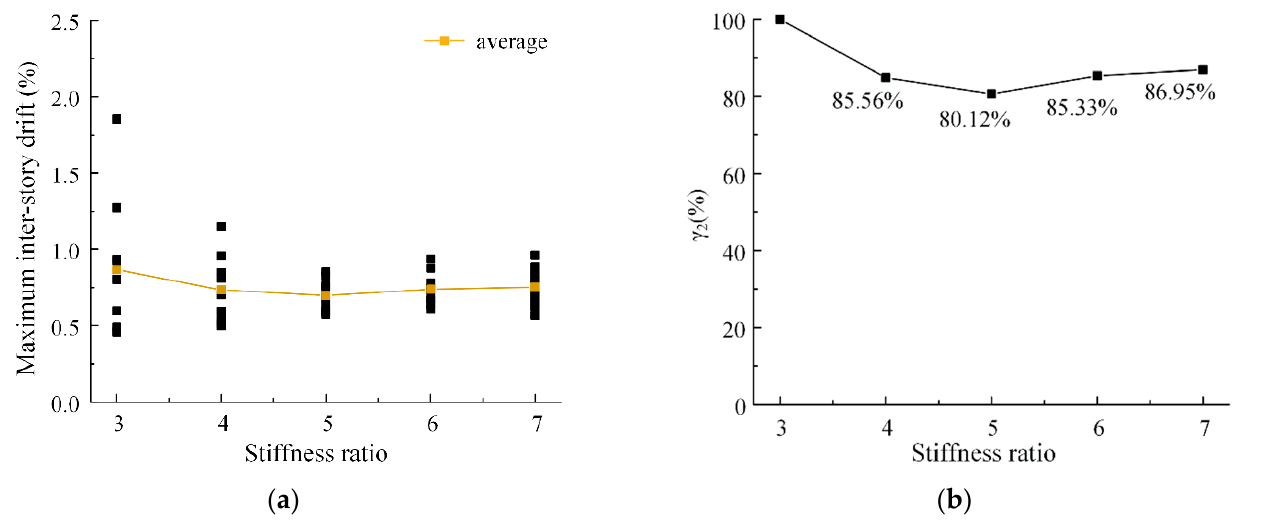
Figure 19. Average maximum inter-story drift of the 12-story PCF-BRB structure: ( a ) changes and ( b ) average ratio.